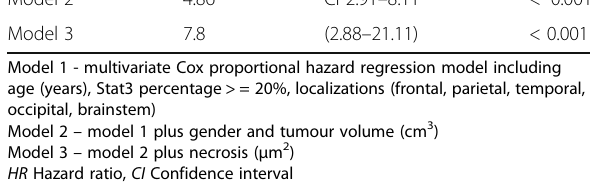
HR Hazard ratio, CI Confidence